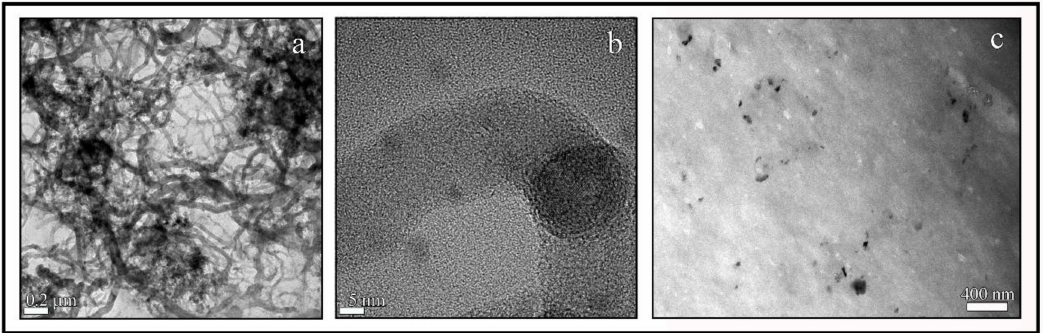
Figure 3. HR-TEM of the CNFs at two magnifications ( a , b ) and TEM of A18-CNFs ( c